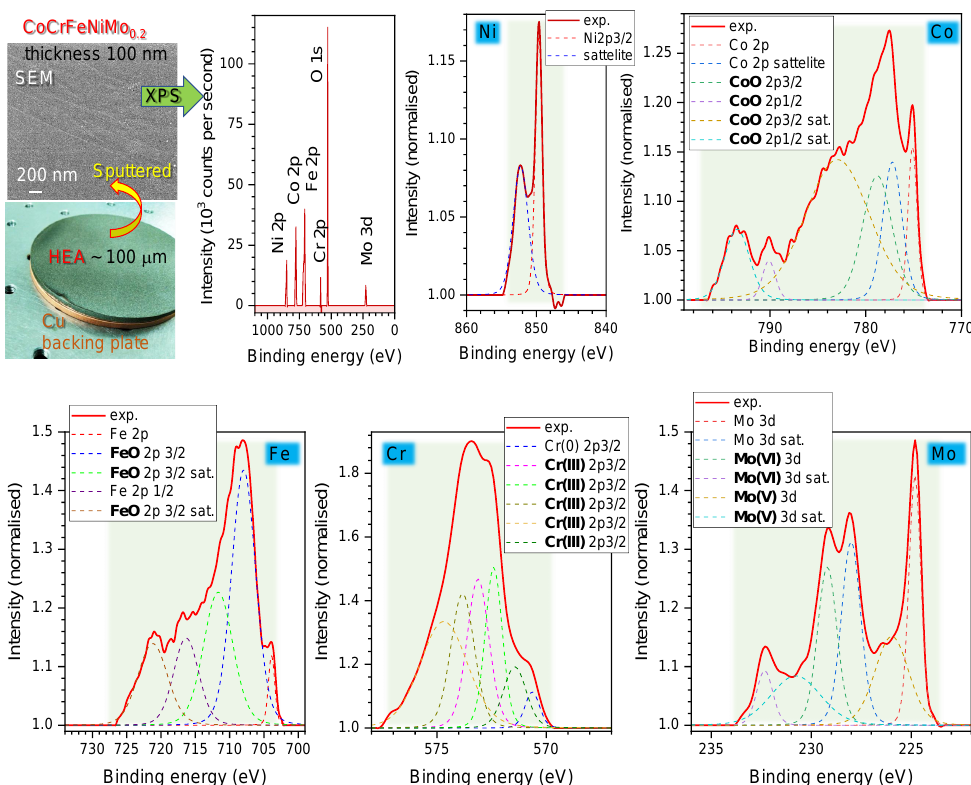
Figure 6. X-ray photoelectron spectroscopy (XPS) of CoCrFeNiMo 0.2 100-nm-thick film transferred on a cover glass by magnetron sputtering. Such a film was used as as a carrier for LIFT. Magnetron sputtering was carried out at the order of 10 − 3 Torr. The CasaXPS software package was used for XPS data analysis. A wide-range binding energy spectrum and detailed elemental bands (normalised) are shown; background highlights (green) show the energy window used for quantification. Bold markers in the legends are for the oxide states: CoO, FeO, Cr(III) [chromia Cr 2 O 3 ], Mo(VI) [MoO 3 ], and Mo(V) [Mo 2 O 5